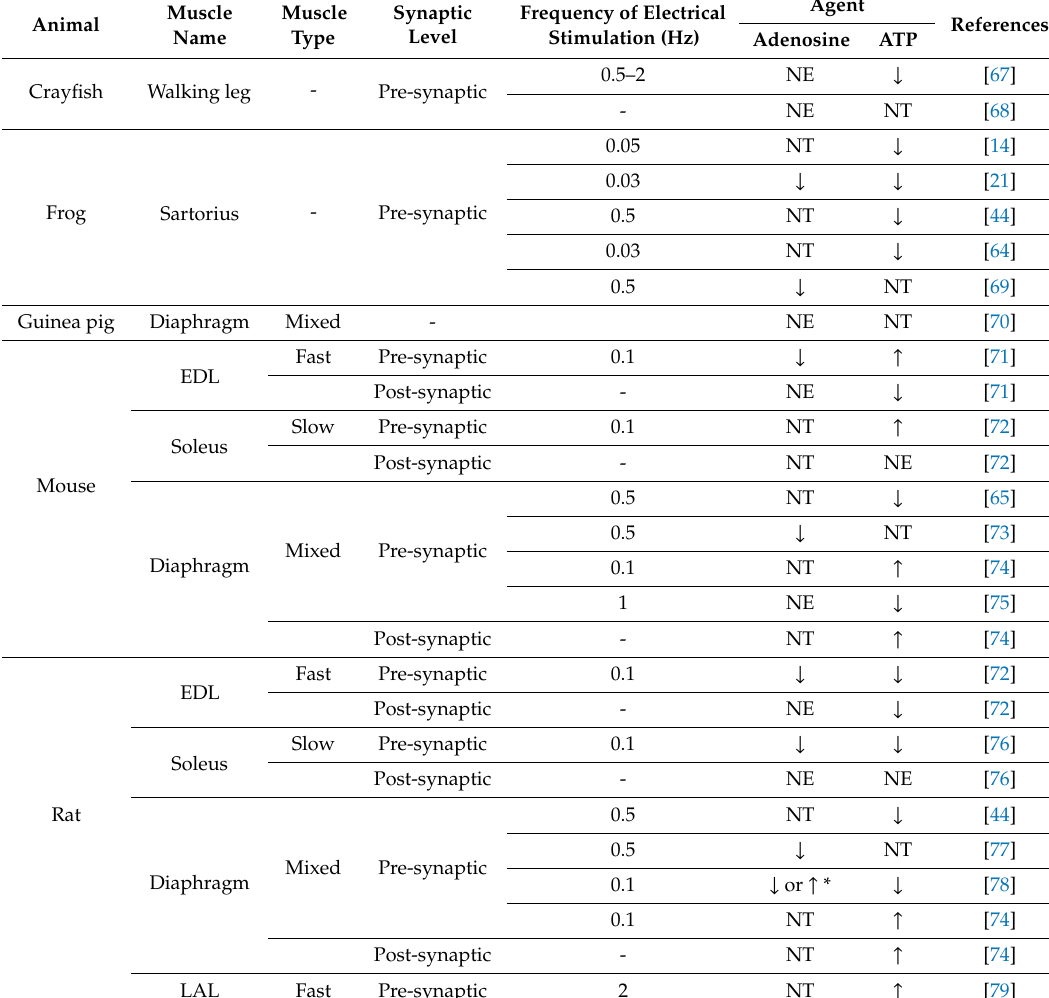
Table 1. E ff ects of adenosine and ATP at neuromuscular junctions of various types of skeletal muscle. Muscle Muscle Animal Name